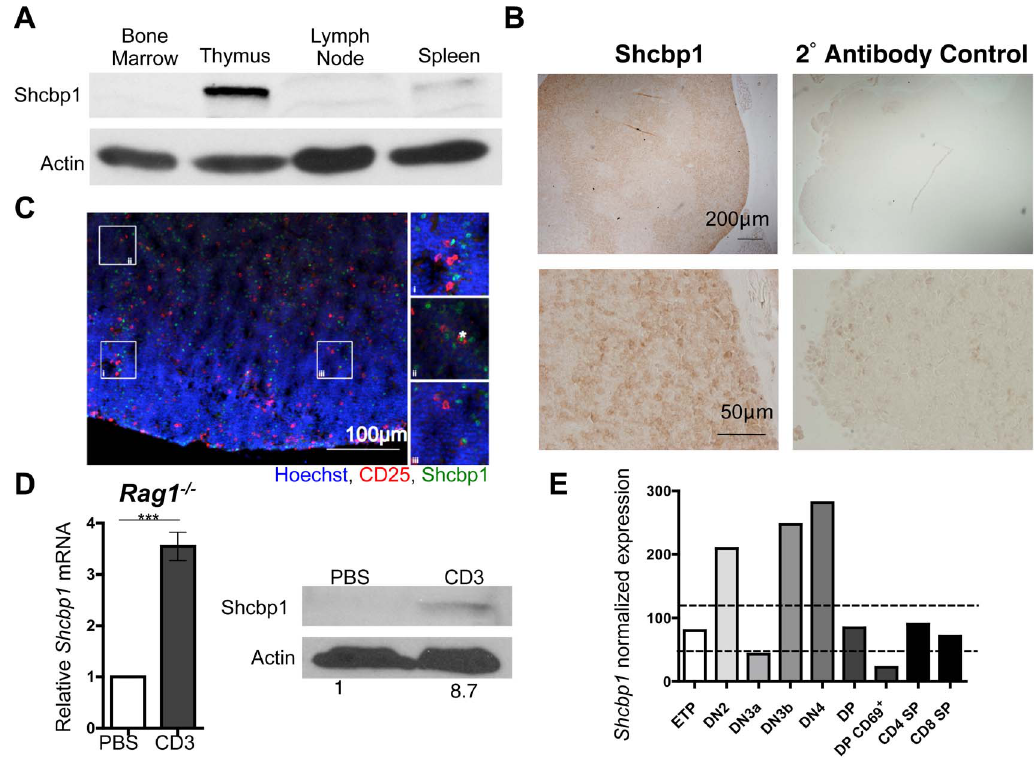
Figure 1. Expression of Shcbp1 during T cell development tightly correlates with proliferative stages. (A) Immunoblotting of Shcbp1 in the indicated tissues of a naı¨ve C57BL/6J mouse (representative of n=3 mice). (B) Left, immunohistochemistry of Shcbp1 in paraffin embedded thymic tissue from the C57BL/6J mouse (representative of n=4 mice). Right, secondary antibody control staining. (C) Immunofluorescence of Shcbp1 and CD25 in frozen thymic tissue from the C57BL/6J mouse (representative of n=2 mice). (D) Left, Shcbp1 mRNA expression in thymocytes from Rag1 2 / 2 mice injected with either PBS or 100 m g of anti-CD3 antibody for 24 hours (n=6 mice of each treatment, p , 0.0001). Right, representative immunoblot of Shcbp1 with quantification. (E) Shcbp1 mRNA expression analyzed by microarray in electronically sorted thymic subsets (data curated from the Immgen Database). Normalized expression value lower than 47 represents a gene that has a $ 95% probability of being a silent gene, while a normalized value of greater than 120 represents a gene that has a $ 95% probability of having true